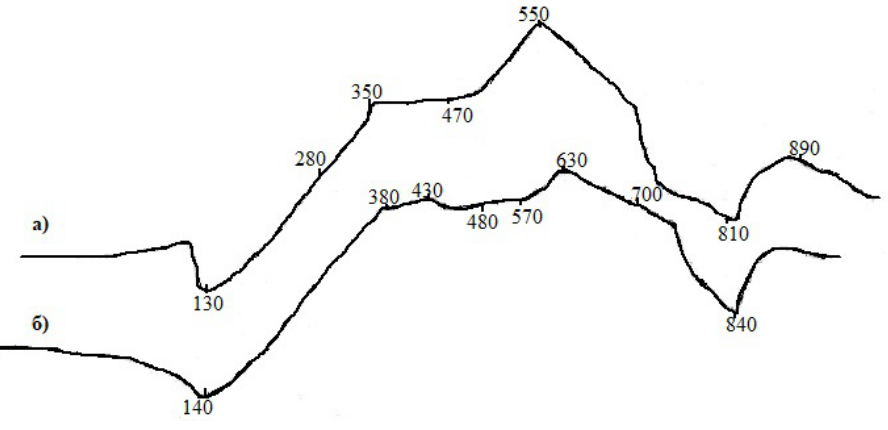
Fig. 8. Derivation: a) experimental and b) control soil- concrete samples (DThA) ( consistence 4)